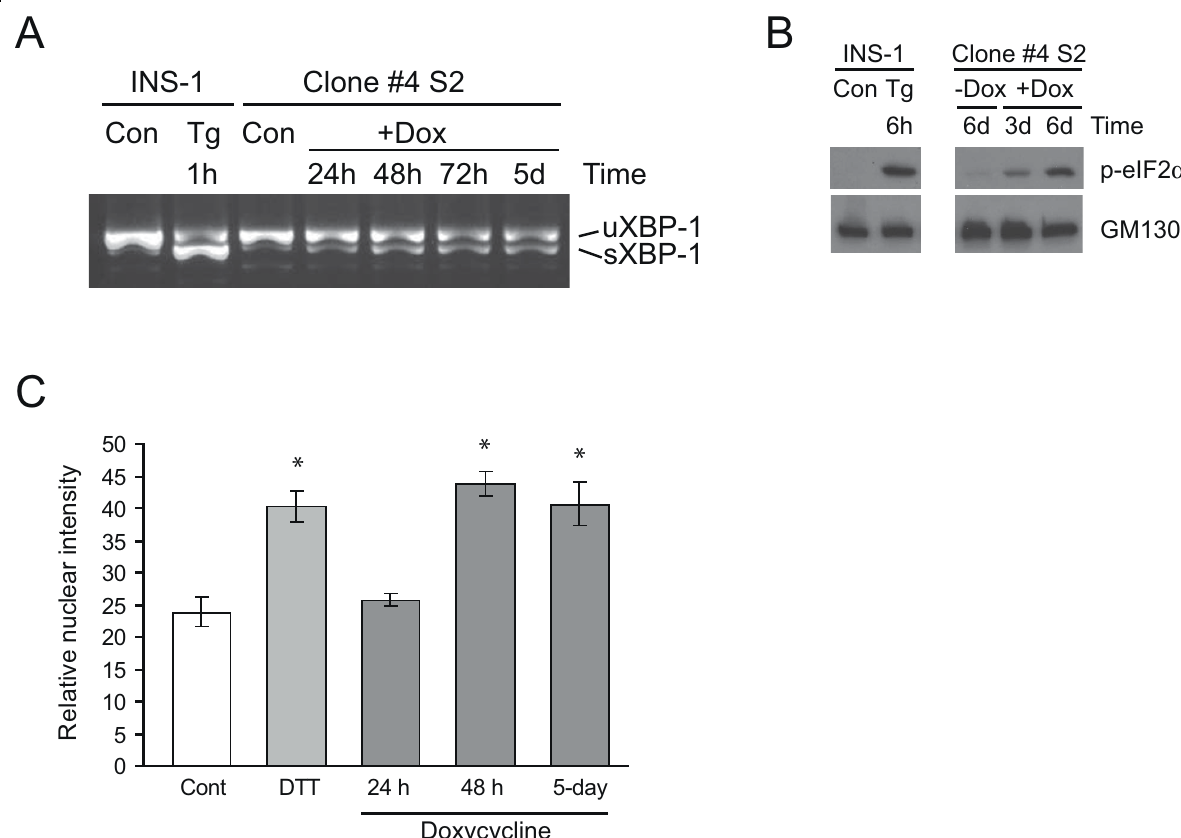
Figure 4 ER stress signaling pathways are activated by insulin 2 (C96Y)-EGFP expression . Clone #4S2 cells were untreated (-Dox) or treated with 2 μ g/ml doxycycline (+Dox) for the times indicated. Control INS-1 cells exposed to thapsigargin (Tg) or dithiothreitol (DTT) were used as a positive control. A . RNA was isolated from the cells and XBP-1 cDNA was amplified by RT-PCR. The unspliced form of XBP-1 (uXBP-1, 480 bp) and spliced form of XBP-1 (sXBP-1, 454 bp) are indicated. B . Clone #4S2 cells were treated as in (A), washed in PBS and lysed. Equal amounts of protein were resolved by SDS-PAGE and immunoblotted with anti-phospho-eIF2 a and GM130 antibodies. C . Clone #4S2 cells were treated with 1 mM dithiothreitol (DTT) for 30 min. or doxycycline as indicated and fixed for immunofluorescence labeling with anti-ATF6 antibody. Nuclear fluorescence of ATF6 was quantified as described in the